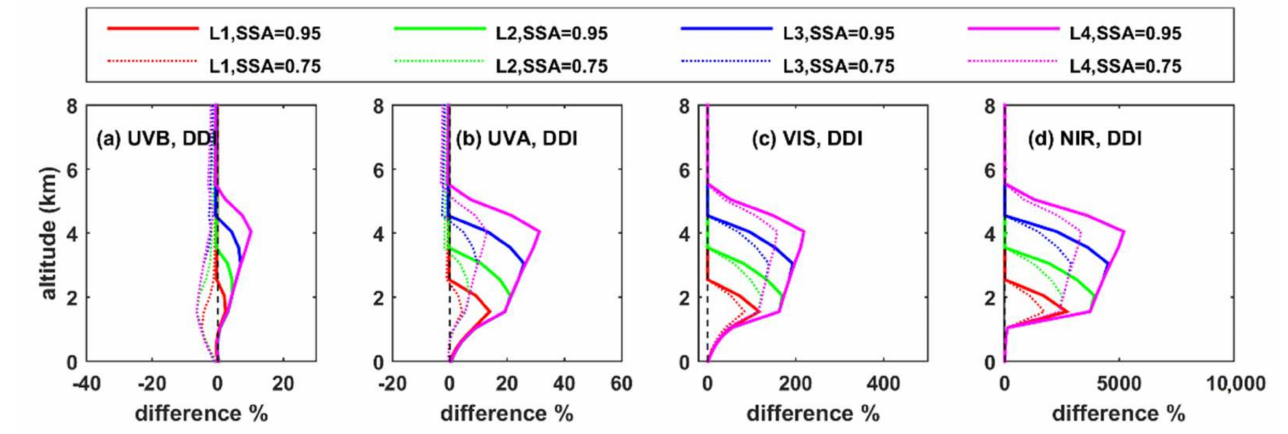
Figure A6. Same as Figure 4, but for AOD = 0.2 instead of AOD = 1.